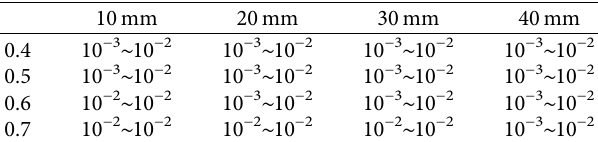
Figure 3: The permeation velocity of the mass loss stage varied for different samples. (a) n � 0.4. (b) n � 0.5. (c) n � 0.6. (d) n � 0.7. Table 2: The change of magnitudes of permeation velocity in the whole